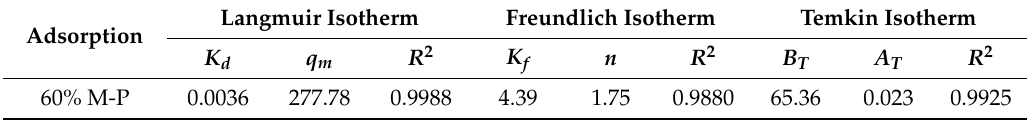
Figure 9. Adsorption capacity estimation for acetone adsorption ( n = 3). Table 2. Langmuir, Freundlich and Temkin constants for acetone adsorption with 60%